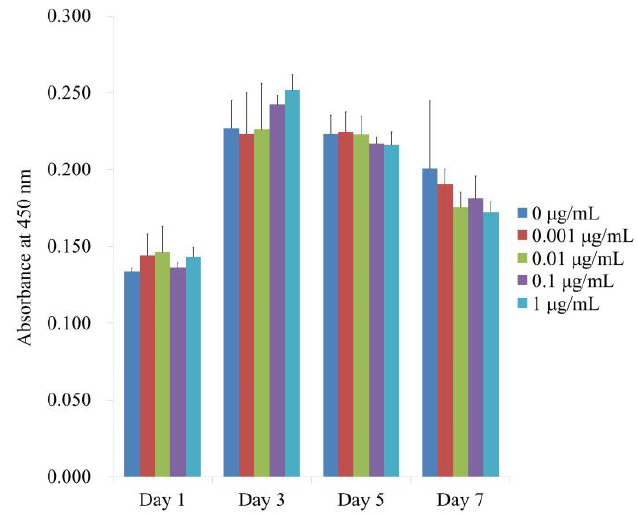
Figure 4. Days 1, 3, 5, and 7 of the CCK-8 assay for cellular viability. Cellular viability was not significantly altered by the application of CMT ( p > 0.05). Additionally, there were no discernible differences between the groups with prolonged incubation durations ( p > 0.05).